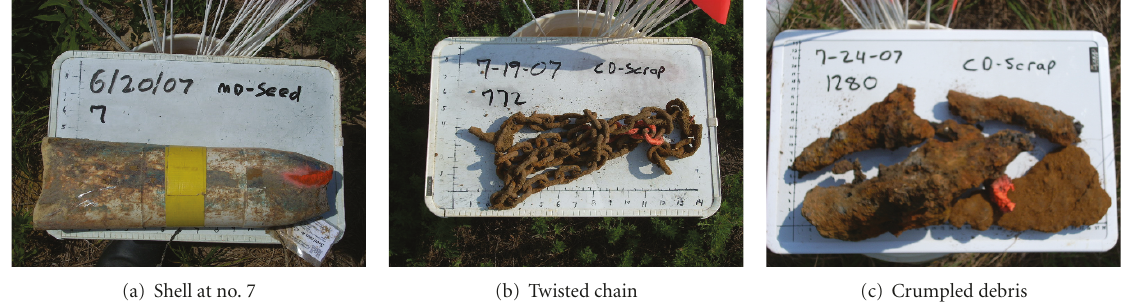
Figure 5: (a) Unexploded shell from Cell no. 7, and (b), (c) the two false alarms obtained by the SVM classifier using k and R as discriminators.